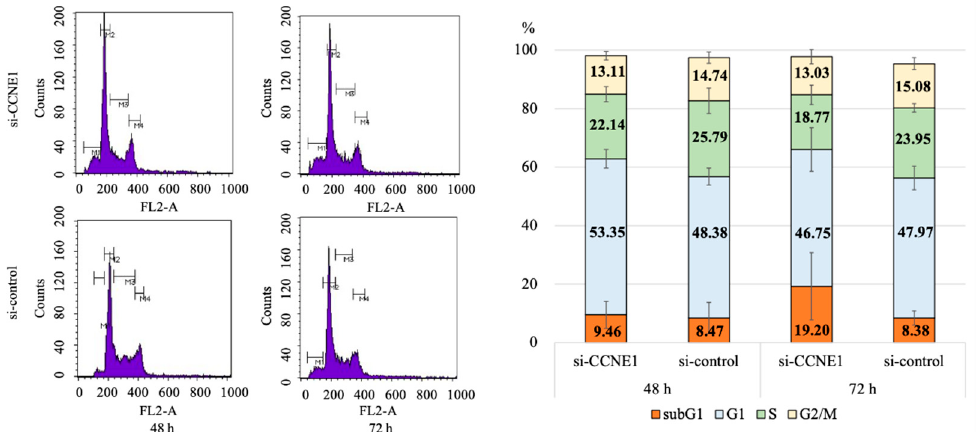
Figure 4. Cell cycle analysis using TOV-21G ( ARID1A mutant line) under CCNE1 interference ( n = 3 per group). CCNE1 interference resulted in an increasing trend in the proportion of the sub-G1 phase and a decrease in the S phase compared with those in the control group. M1, M2, M3 and M4 refer to the sub G1, G1, S and G2/M phases, respectively. There were three biological replicates, shown by mean (SD).